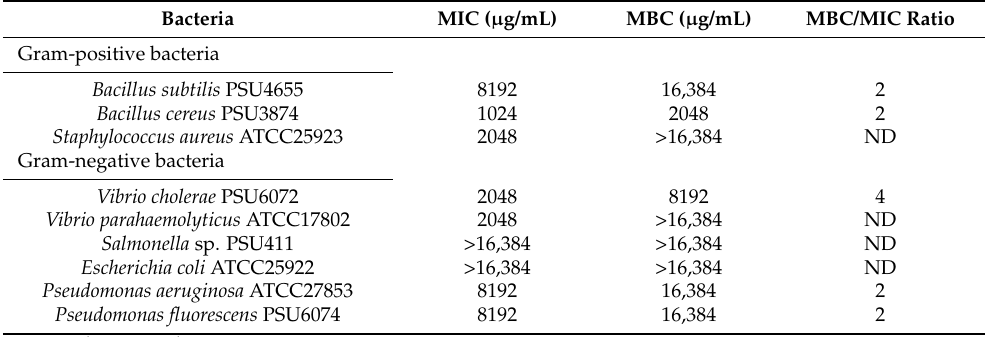
Table 3. The MIC and MBC values of rambutan peel extract (RPE) against various food pathogenic and spoilage